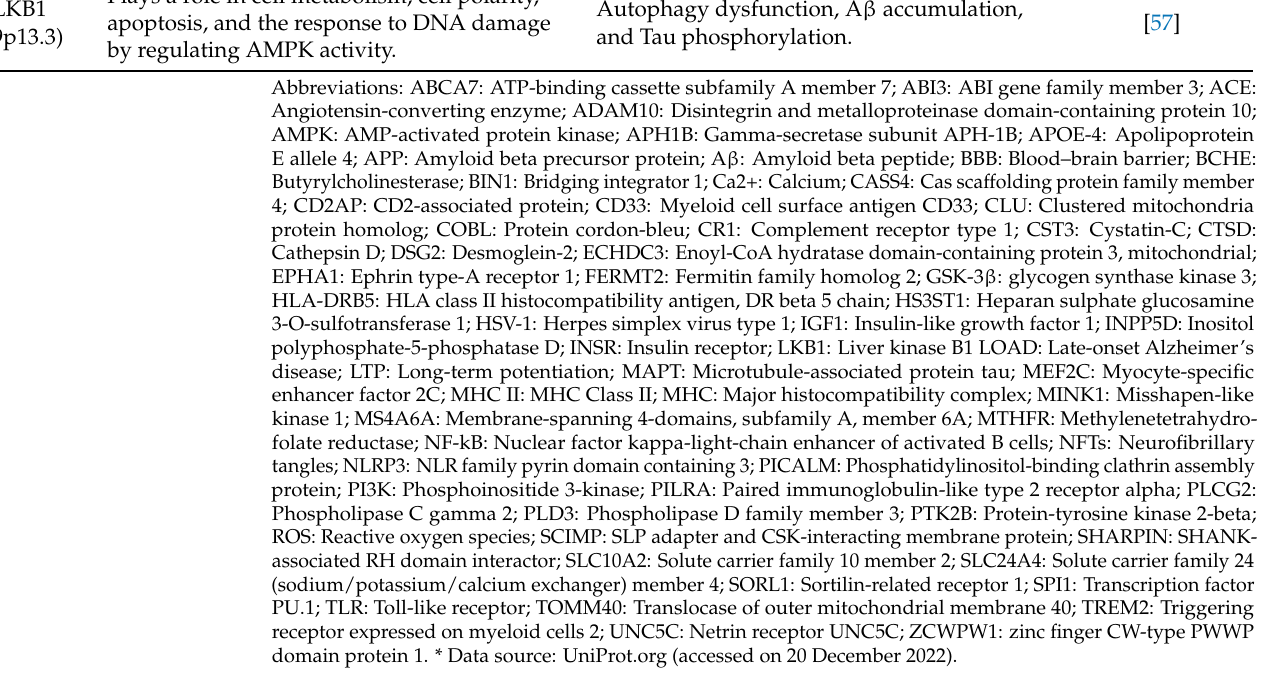
Table 1. Cont. Gene/ Physiological Role * Molecular Mechanisms Implicated in AD Ref. Location Plays a role in cell metabolism, cell polarity, LKB1 apoptosis, and the response to DNA damage (19p13.3) by regulating AMPK